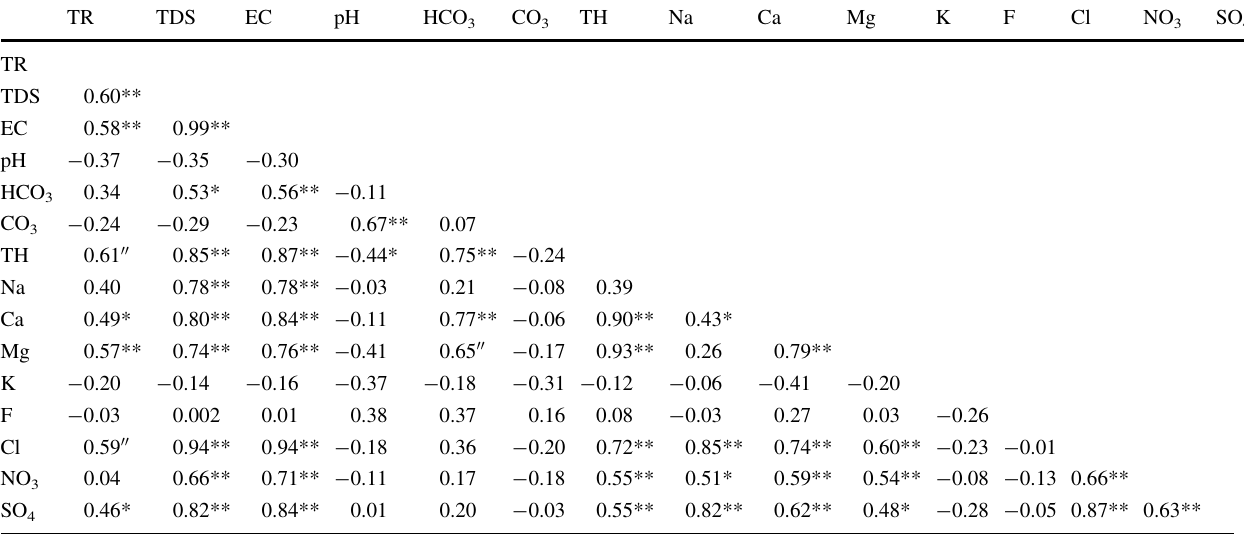
Table 8 Correlation matrix among different water quality parameters for groundwater resources of the study area sampled during